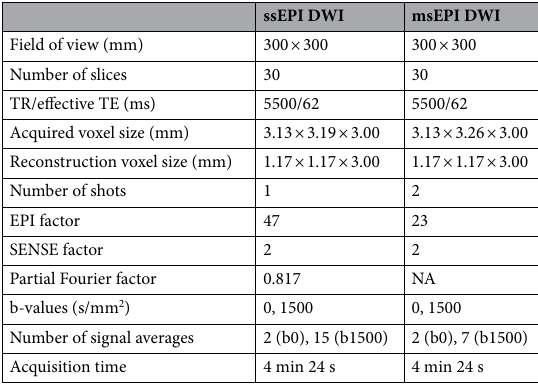
Table 1. DWI imaging